Question: Provide a publication-style caption for this figure.
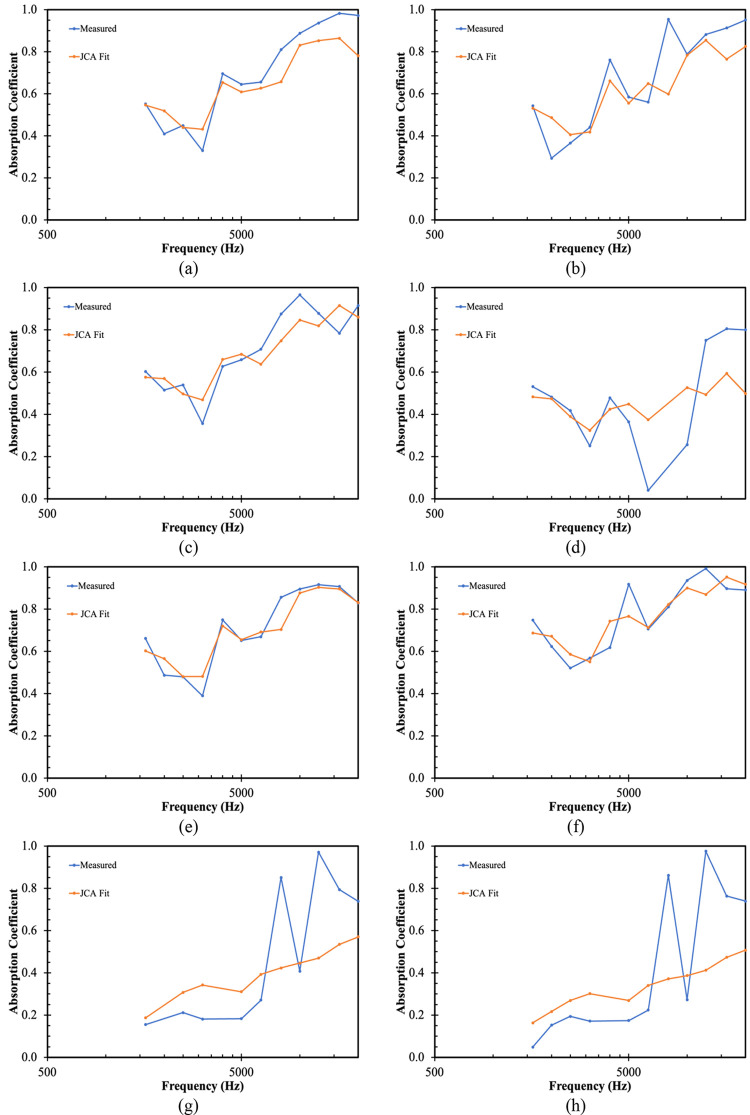
Answer: Comparison of measured and JCA-predicted acoustic absorption for 3D-printed PLA and biocomposite samples: (a) coffee_gyroid10% ( R 2 = 0.805), (b) cork_gyroid10% ( R 2 = 0.634), (c) cork_gyroid20% ( R 2 = 0.792), (d) PLA_gyroid10% ( R 2 = 0.321), (e) PLA_gyroid20% ( R 2 = 0.882), (f) PLA_gyroid30% ( R 2 = 0.775), (g) PLA_grid10% ( R 2 = 0.340), and (h) PLA_trihexagonal10% ( R 2 = 0.369).